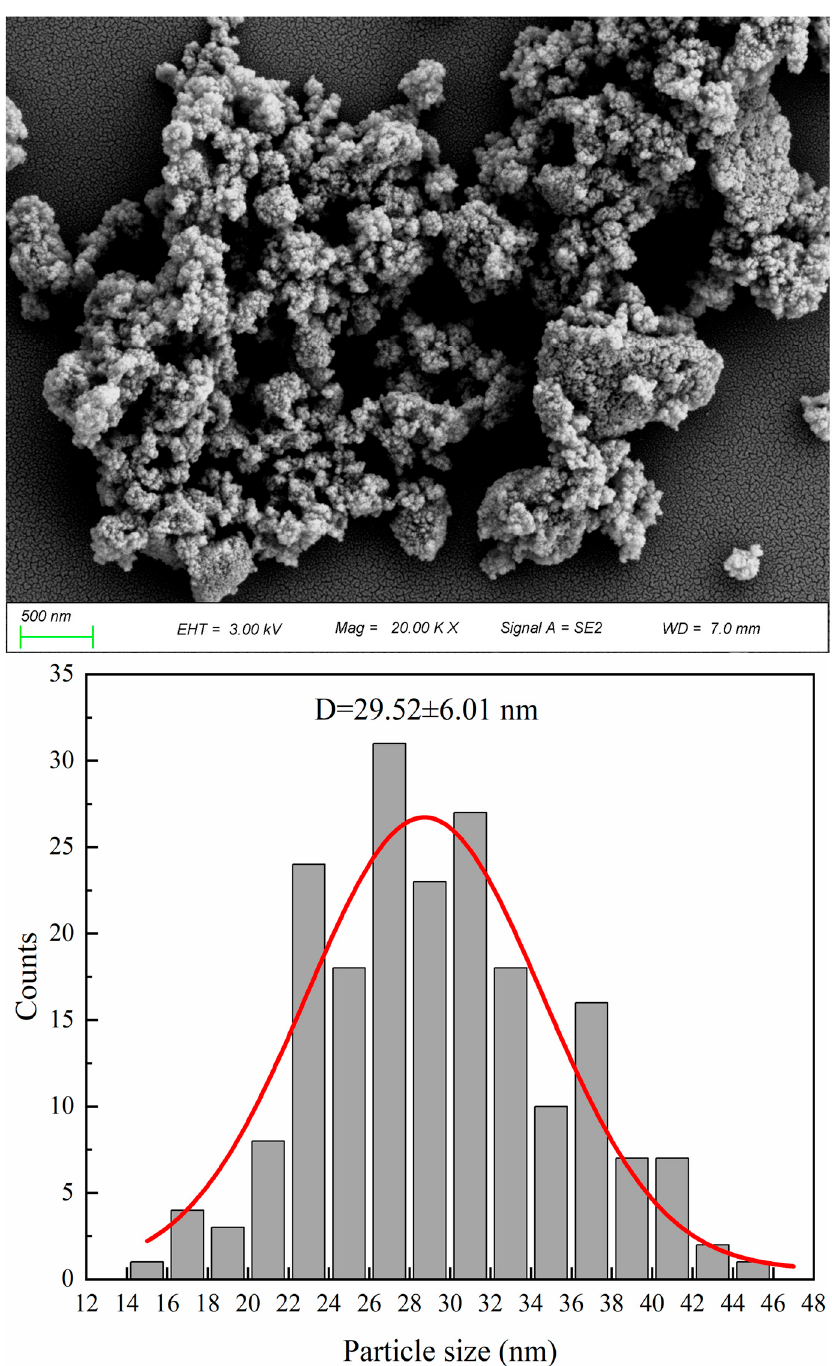
Figure 7. SEM image and particle size distribution of catalyst Fe 3 O 4 @SiO 2 -Oc&PrSO 3